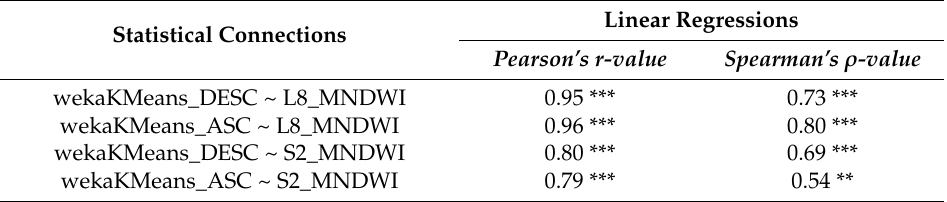
Figure 8. Linear regression lines (blue lines) between monthly water coverage (in ha) calculated from the radar and the water index (reference) data—the red line is an exponential fit, but for informative purposes only; L8_MNDWI and S2_MNDWI are for the water cover data derived from Landsat 8 and Sentinel-2 images, respectively. Table 2. Pearson’s and Spearman’s correlation coe ffi cients for the linear